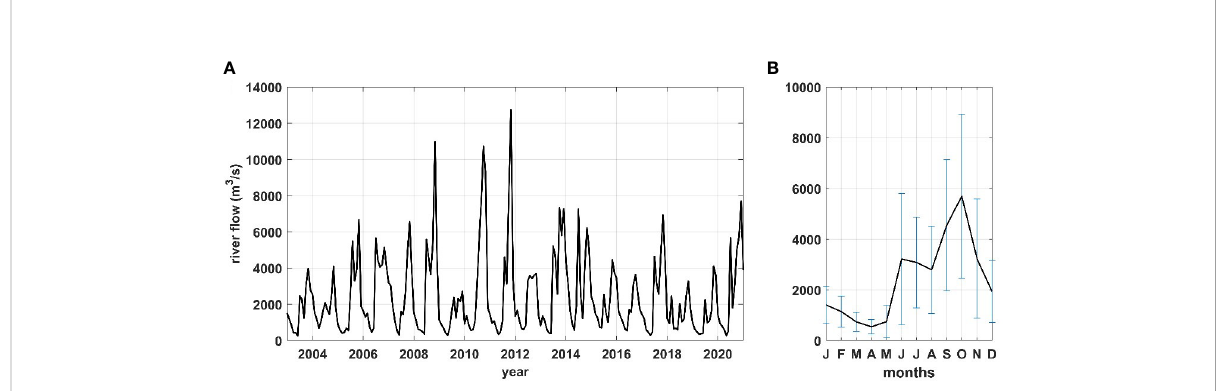
FIGURE 2 Flow of the Grijalva-Usumacinta River System (m3s -1 ). (A) 2003-2020 time series and (B) Monthly climatology and its standard deviation (blue